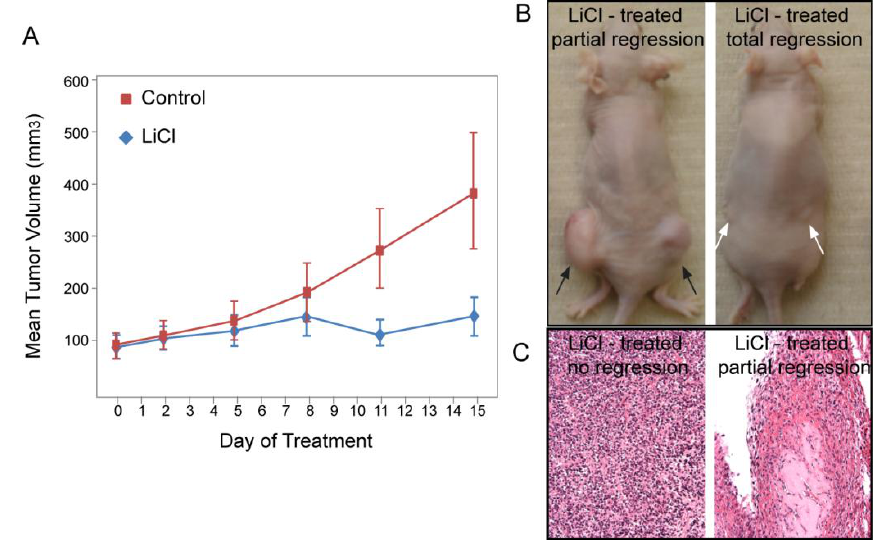
Figure 7. LiCl treatment reduced endometrial tumor mass in vivo . ( A ) Nude mice bearing AN3CA xenografts were treated with either control or LiCl-supplemented drinking water after the tumors were established (average tumor mass 100 mm 3 ). Two weeks into treatment lithium-treated mice showed a significantly reduced tumor size ( p = 0.0024); ( B ) Representative mice treated with LiCl showed partial (black arrows) or complete (white arrows) regression of the tumor; ( C ) Histological appearance of the partially regressed and fully regressed